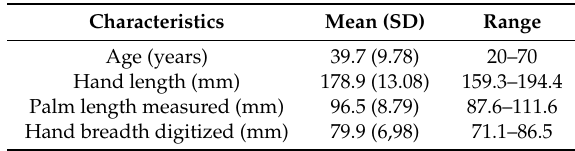
Table 1. Anthropometric data of the study’s participants (n =